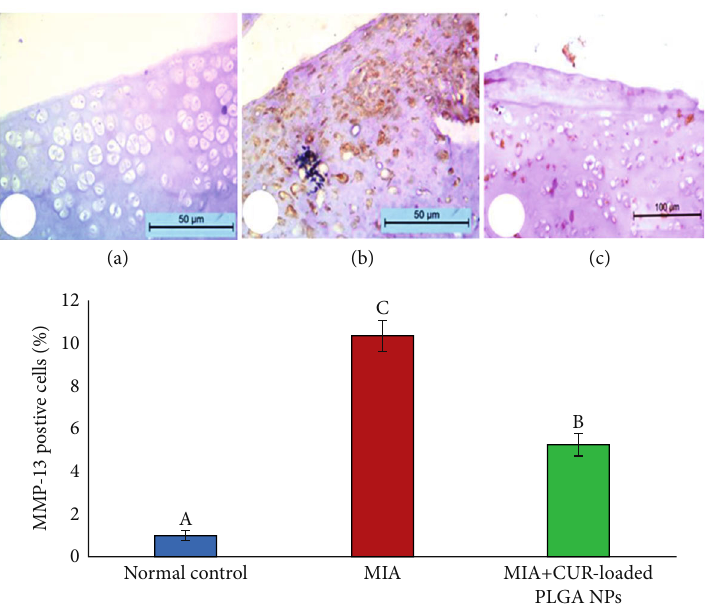
Figure 10: Photomicrograph showing immunostaining results of matrix metalloproteinase-1 (MMP-13) expression in cartilage tissue in the (a) normal control group, (b) MIA-treated group, and (c) MIA+CUR-loaded PLGA NP group. Stained cells (brown) were counted, and the percentage of positive cells is expressed as mean ± standard error of the mean (SEM), where n = 6 and P < 0 : 05 .